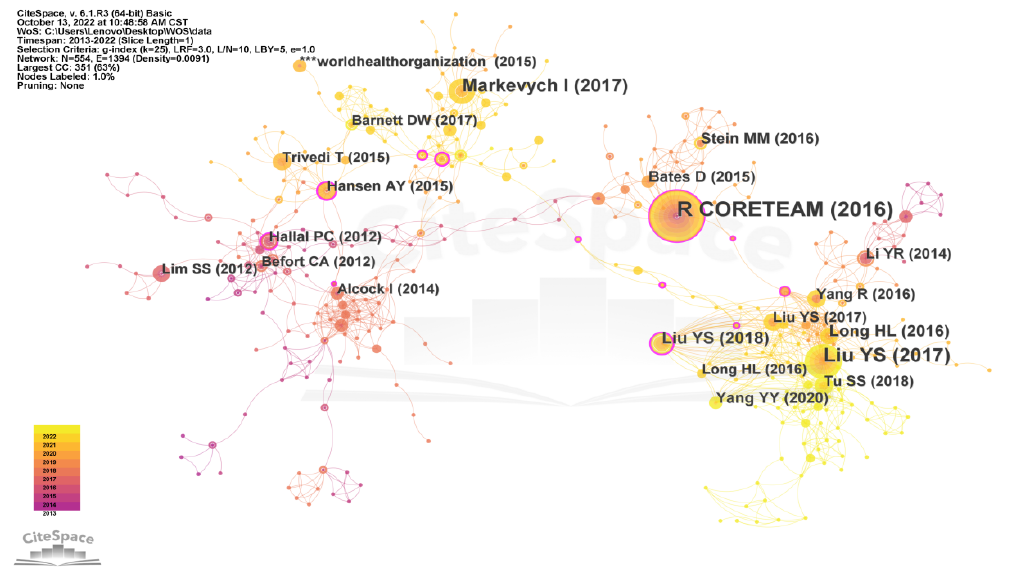
Figure 15. The citation network of rural human settlement environment research. Table 6. Key literature nodes of rural human settlement environment research.